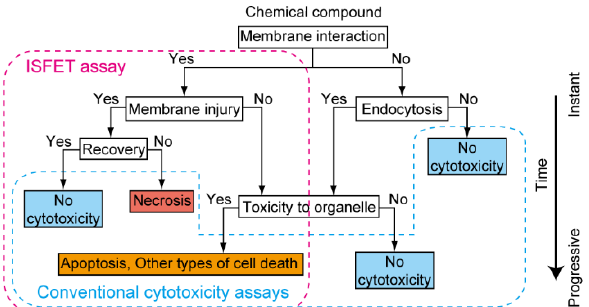
Figure 4. Flow chart showing an invasion of a toxic chemical compound into various cytosolic compartments and the assays that monitor different aspects of time-dependent cytotoxic processes. An invasion of toxicant to the plasma membranes or organelle leads to eventual cell death via different pathways. The ISFET assay detects plasma membrane leakage instantaneously or apoptosis-mediated membrane disorder in several hours. Conventional assays monitor the consequence of toxic activity in minutes to days. Reproduced from [57] with permission by the Royal Society of Chemistry.